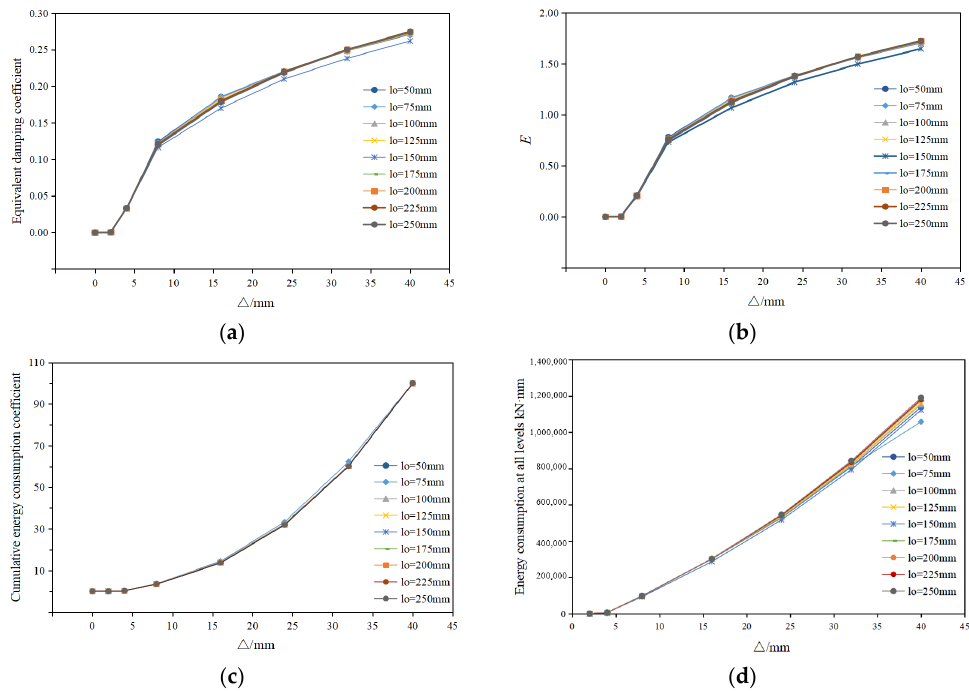
Figure 10. Correlation curve of the energy dissipation capacity of models with different lap lengths. ( a ) Equivalent damping coefficient; ( b ) energy dissipation coefficient; ( c ) cumulative energy dissipation coefficient; ( d ) energy dissipation at each stage. Table 11. Energy dissipation coefficients of models with different lap lengths.